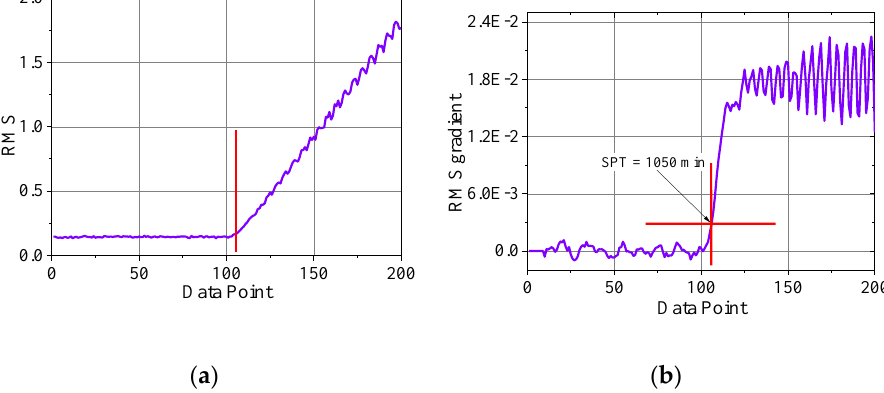
Figure 6. SPT point determination of simulation data: ( a ) RMS and ( b ) RMS gradient.